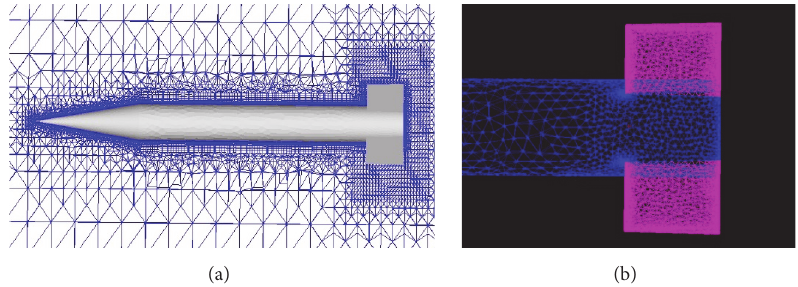
Figure 3: Computational grid without microflaps, expanded near (a) the projectile and (b) afterbody finned region.